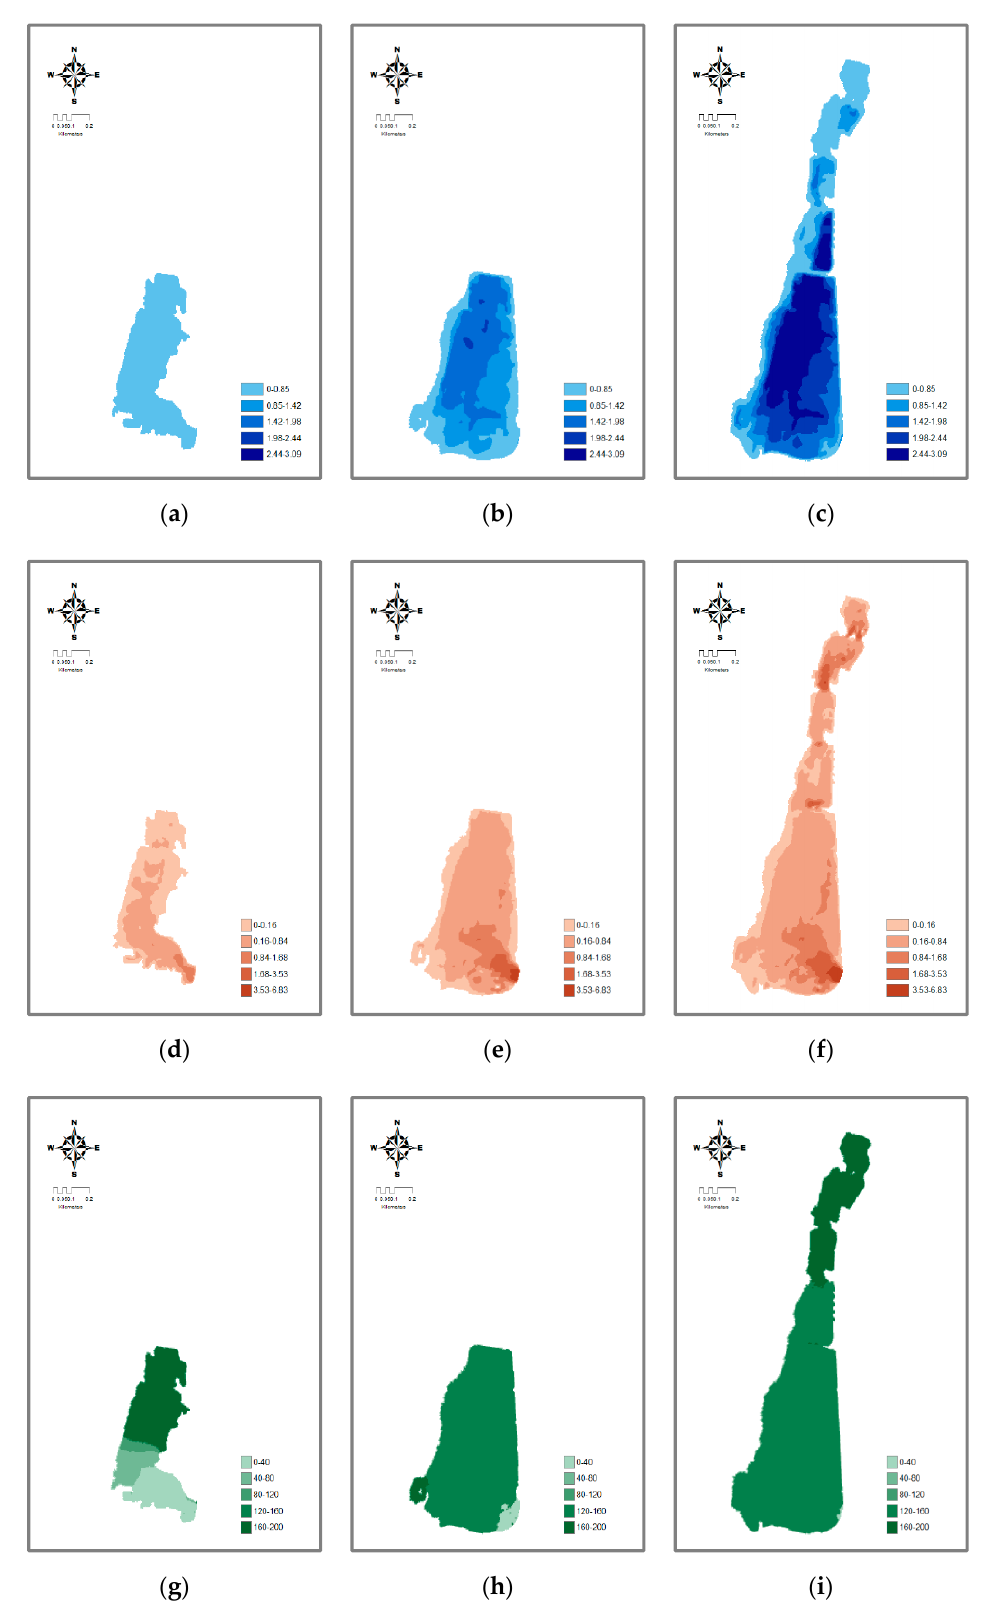
Figure 13. Construction of triangular fuzzy numbers of flood indices for Levee #1 failure, ( a ) Lower layer (depth, a), ( b ) Meidan layer (depth, b), ( c ) Upper layer (depth, c), ( d ) Lower layer (velocity, a), ( e ) Meidan layer (velocity, b), ( f ) Upper layer (velocity, c), ( g ) Lower laye r (travel time, a), ( h ) Meidan layer (travel time, b), and ( i ) Upper layer (travel time, c).